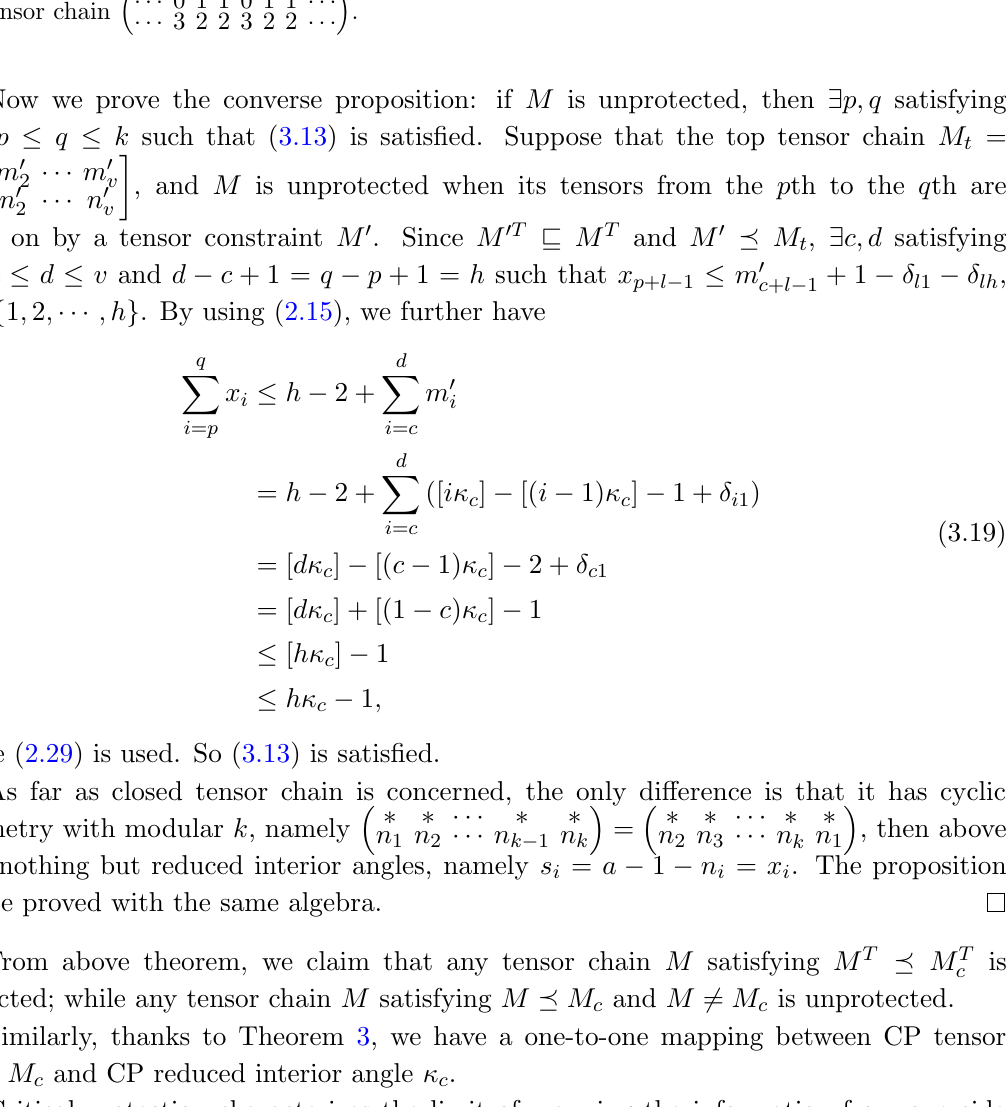
Figure 8 . By using top tensor chain CP tensor chain